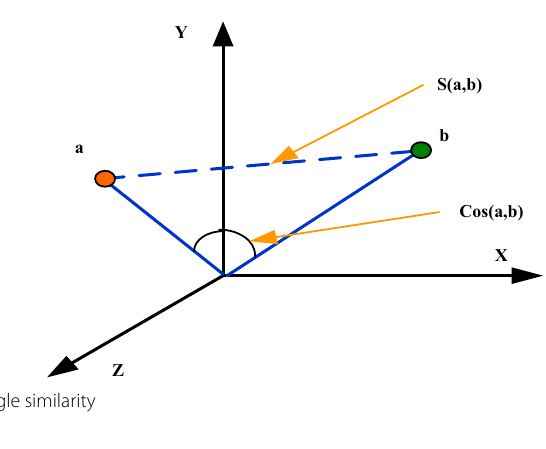
Fig. 6 Cosine angle